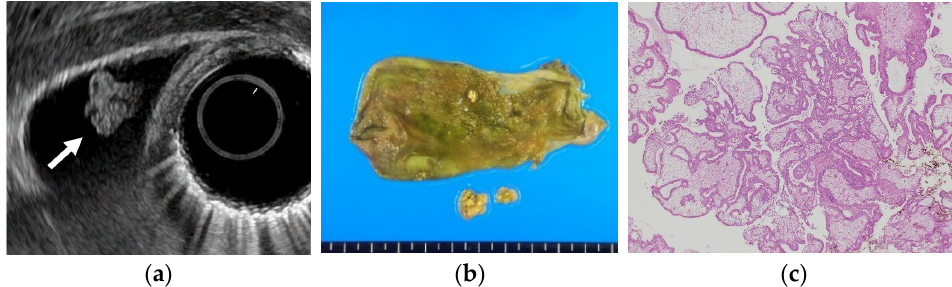
Figure 1. Cholesterol polyp. ( a ) EUS shows a cholesterol polyp as a granular-surfaced pedunculated lesion. The internal echo is heterogeneous with a hyperechoic spot (arrow). ( b ) Photograph of the gross pathologic specimen after cholecystectomy shows a yellowish polyp. ( c ) H-E stain of the specimen demonstrates an aggregation of foamy cells under the epithelium.